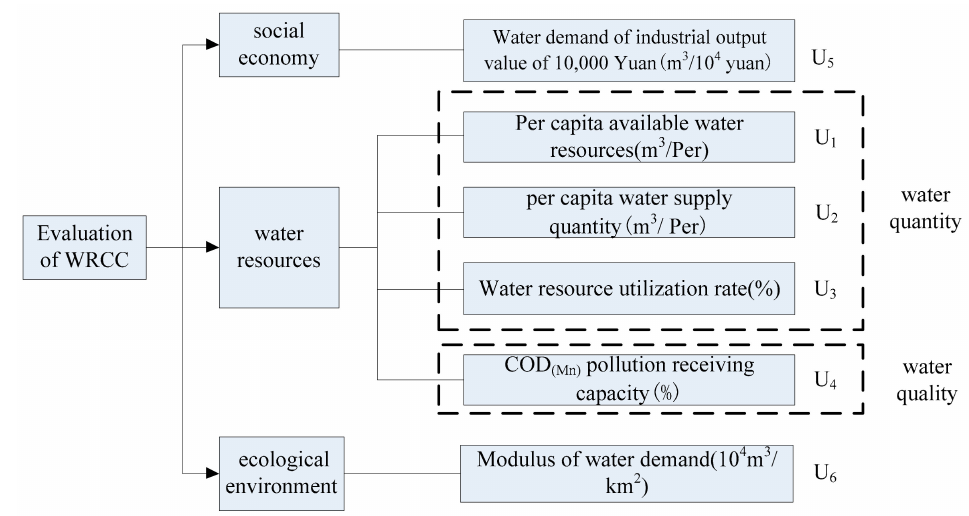
Figure 2. The research system of water resource carrying capacity (WRCC) index